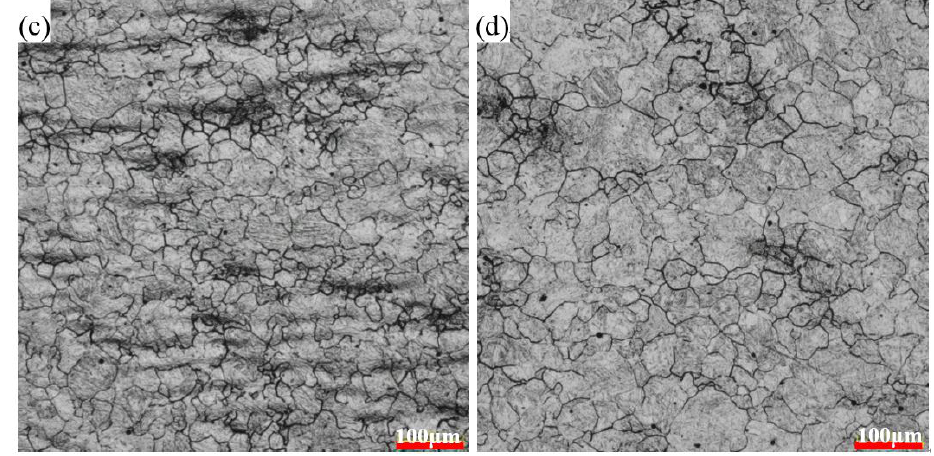
Figure 13. Microstructure corresponding to point A, B, C and D in Figure 9 ( a ) A; ( b ) B; ( c ) C; ( d ) D. DRX: dynamic recrystallization.